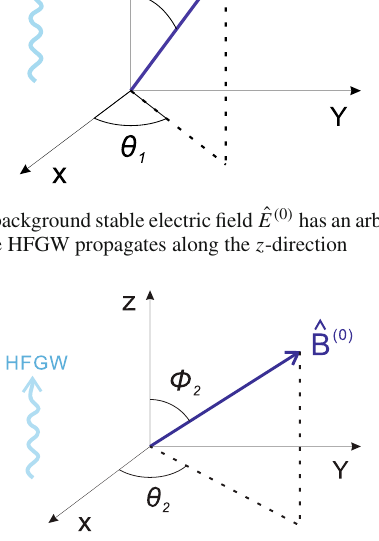
Fig. 2 The background stable magnetic field ˆ B ( 0 ) has also an arbitrary direction. This magnetic field and the background electric field in Fig. 1 are in the same region as the region that the HFGW passes through, and the HFGW propagates along the z